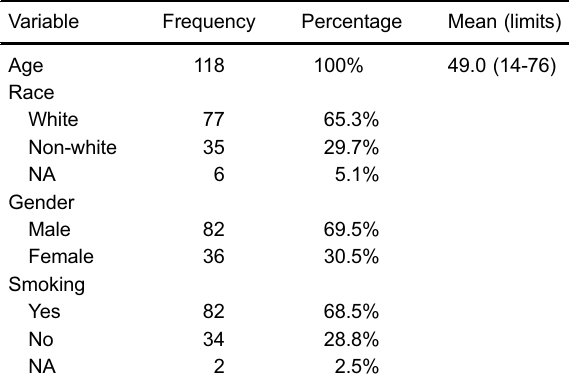
Table 1. Demographic data of patients enrolled in the study.